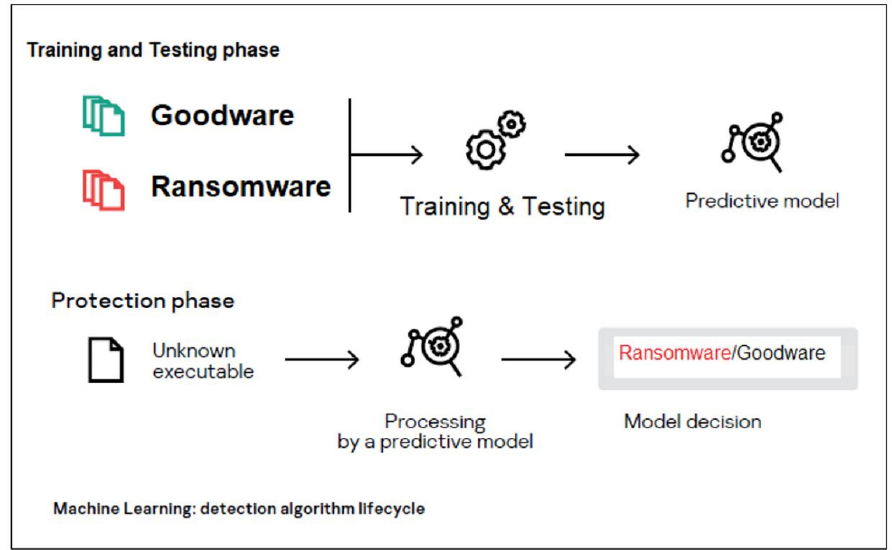
Figure 1. Detection lifecycle.